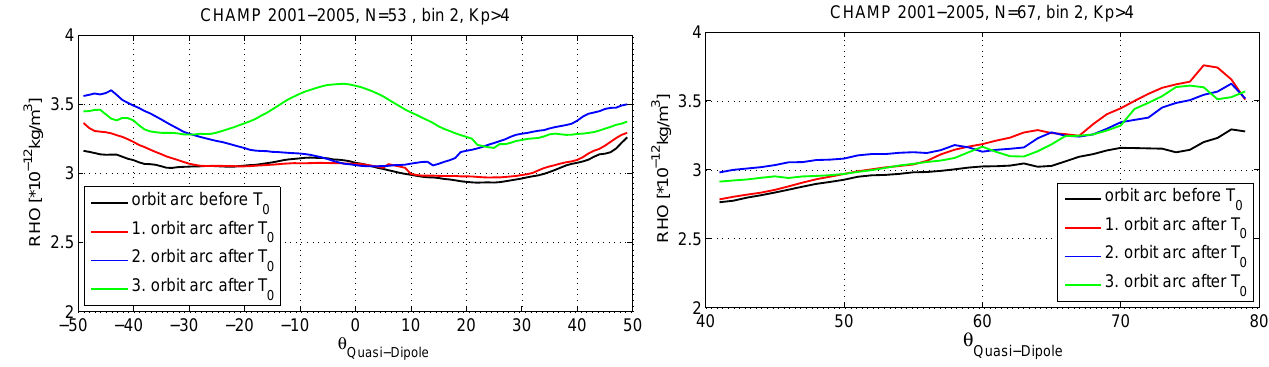
Fig. 3. Mean thermospheric density at low (left frame) and high (right frame) latitudes for Kp > 4 of data subsets in bin 2. Black line: orbit arc before substorm onset T 0 ; red line: 0.25–1.25h after substorm onset T 0 ; blue line: 1.75–2.75h after T 0 ; green line: 3.25–4.25h after T 0 . Calculated mean MLT: 24h. The mean uncertainty of the density curves is ± 0 . 2 × 10 − 12 kg/m 3 .